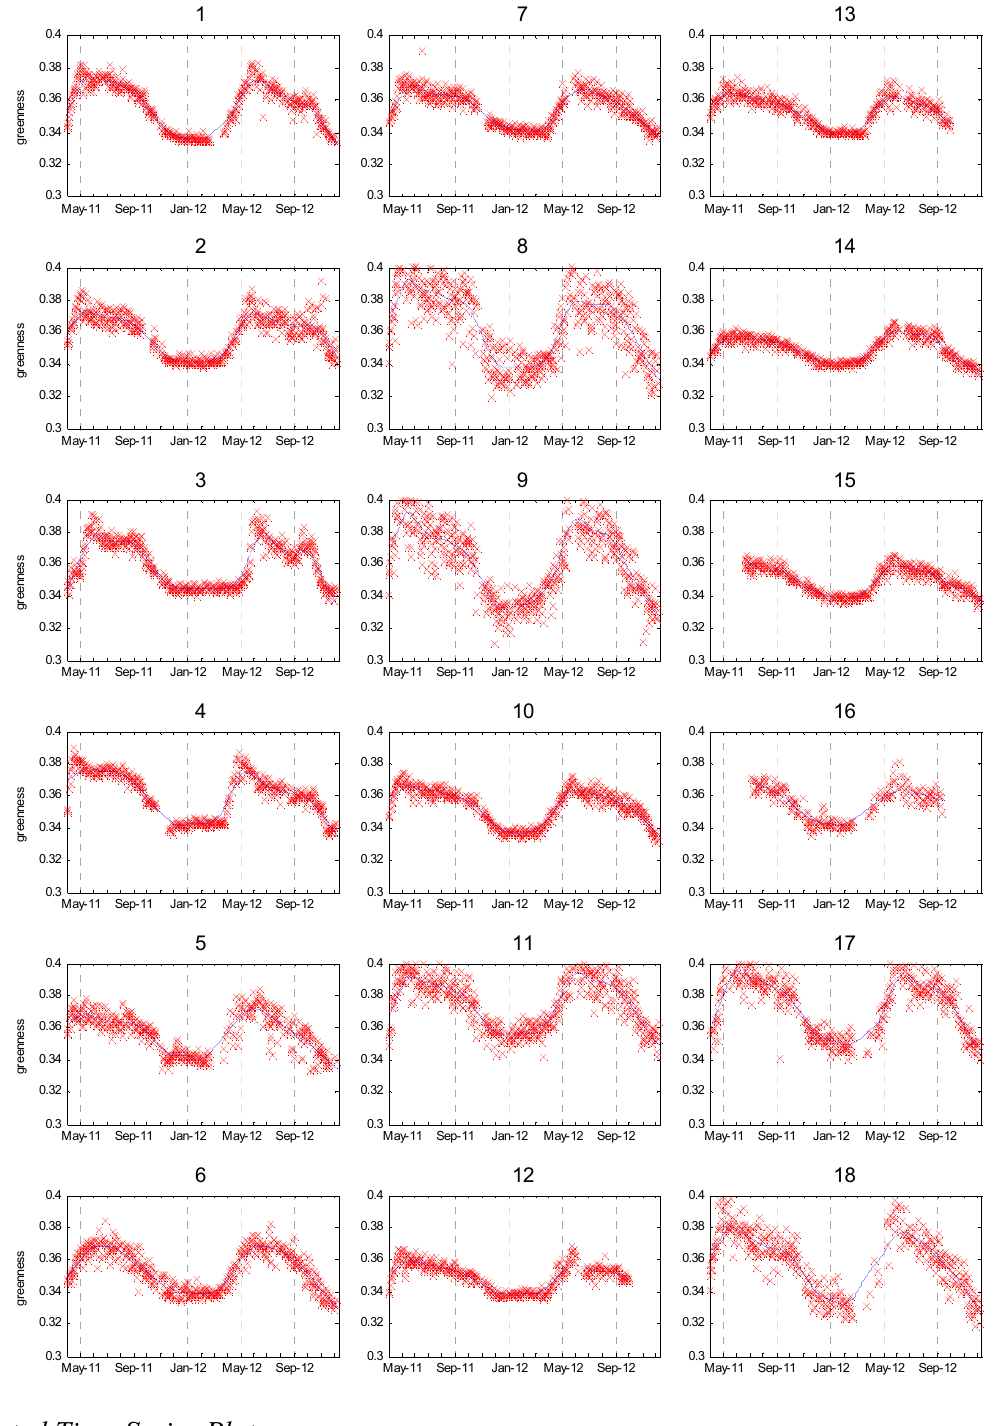
Figure 5. Calculated greenness levels using Equation (1) for each camera shown in Figure 1 over the period of analysis. The crosses show individual data points and the continuous curves show the smoothed data used for date